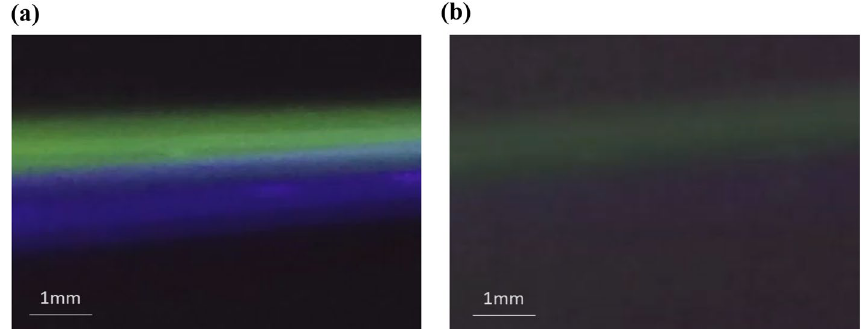
Figure 3. Light scattering images of pure water and air. A blue laser and a red laser are used simultaneously . ( a ) the light scattered by pure water, and ( b ) the light scattered by